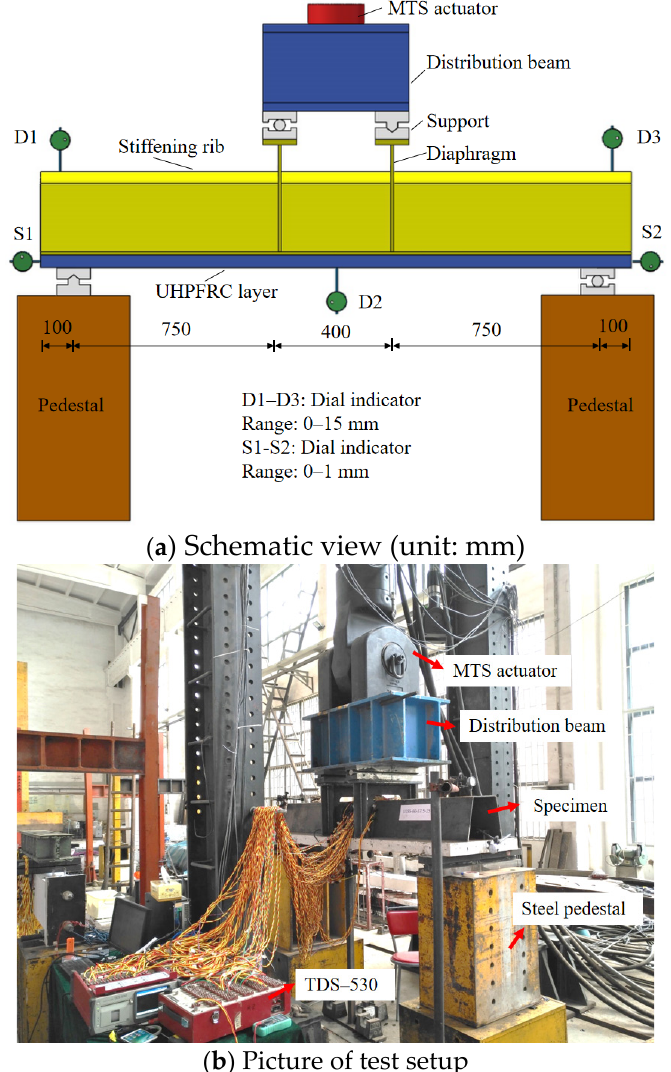
Figure 8. Test setup of steel-UHPFRC composite beam.